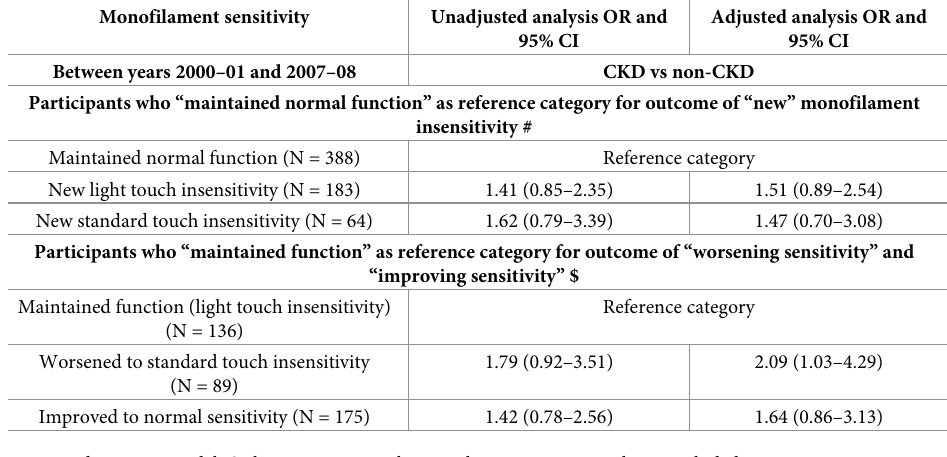
Table 3. Multinomial regression analysis using CKD as predictor variable with outcome of “new” or “worsening” monofilament insensitivity. Monofilament